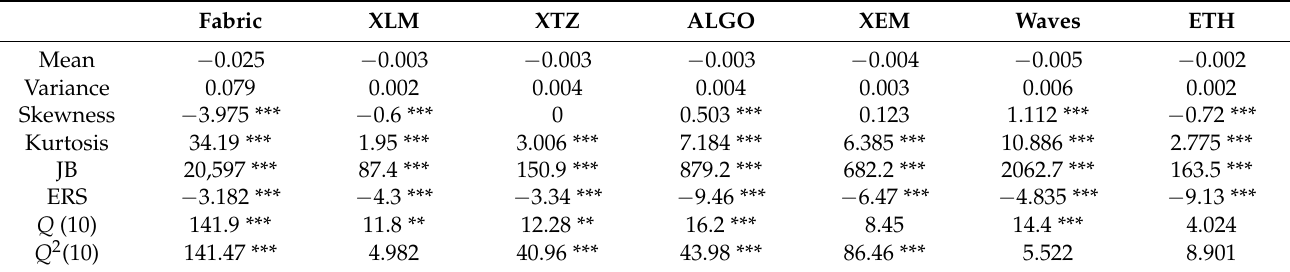
Table 1 offers descriptive statistics. The average returns for all series are negative, in accordance with the decreasing prices throughout the observation period. Barring Fabric, all other SMs have low variances. This observation remains consistent with the fact that most SMs have a steady demand despite shocks due to stressful events. Kurtosis is higher than 3 for four variables, with the exception of XLM, XTZ, and ETH. As most kurtosis is distanced from mesokurtic distribution, most return series are not Gaussian, as illustrated by the JB test statistics. Importantly, the ERS unit root tests suggest that all returns are stationary. Figure 1 shows the development of the SM platform returns over time. The figure illustrates a sudden rise in volatility in XTZ around both Delta and Omicron and Fabric around the Russian invasion of Ukraine. Table 1. Descriptive statistics of all the seven Smart Contract platforms.